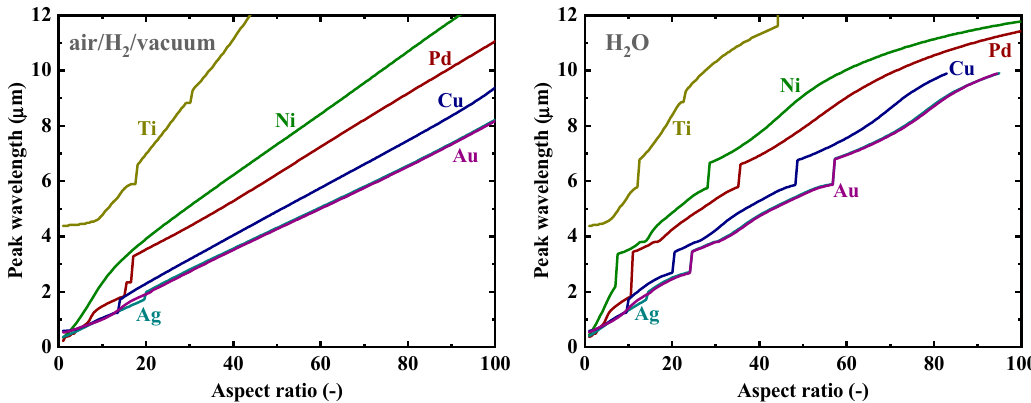
Figure 6. Dependence of the peak electromagnetic field enhancement factors at the tips of spheroidal nanoparticles of Au, Ag, Cu, Pd, Ti, and Ni on the aspect ratio in ( left ) air/H 2 /vacuum and ( right ) H 2 O.